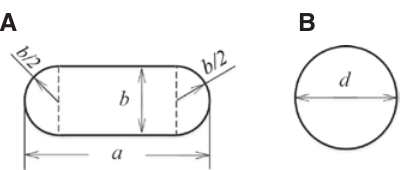
Figure 6: Cross section of tows in different directions.